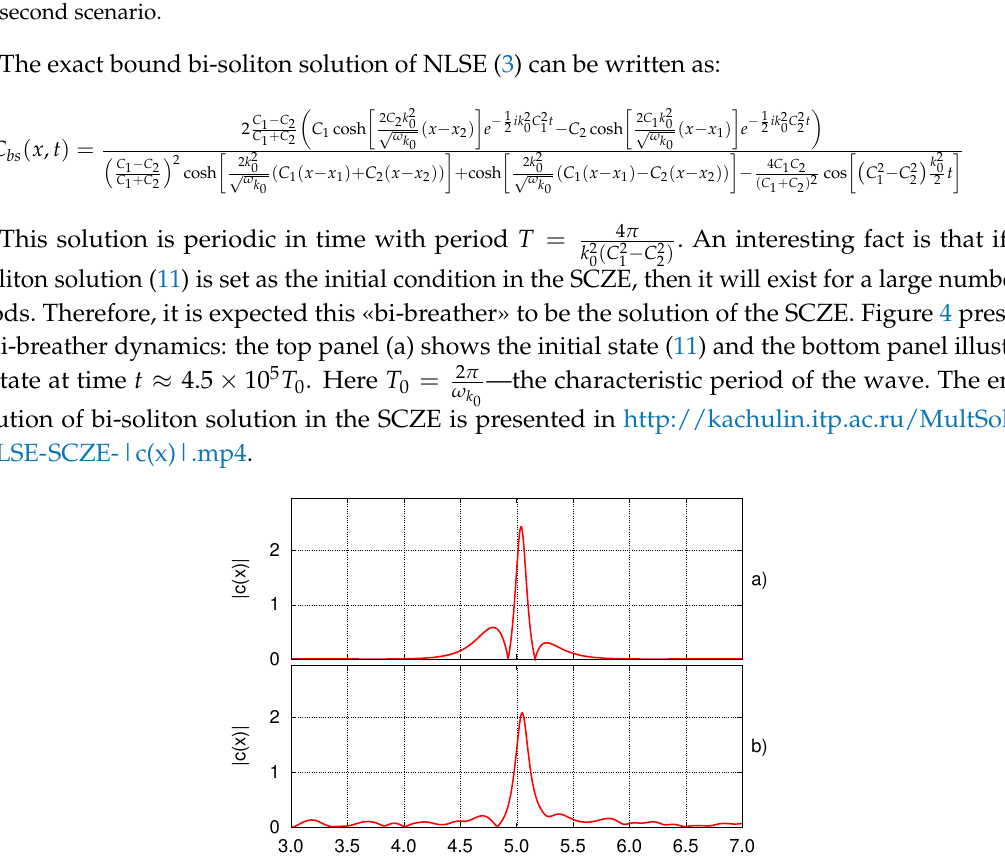
Figure 3. Time dependence for number of particles ( a ), momentum ( b ) and wave number ( c ) in the second scenario.